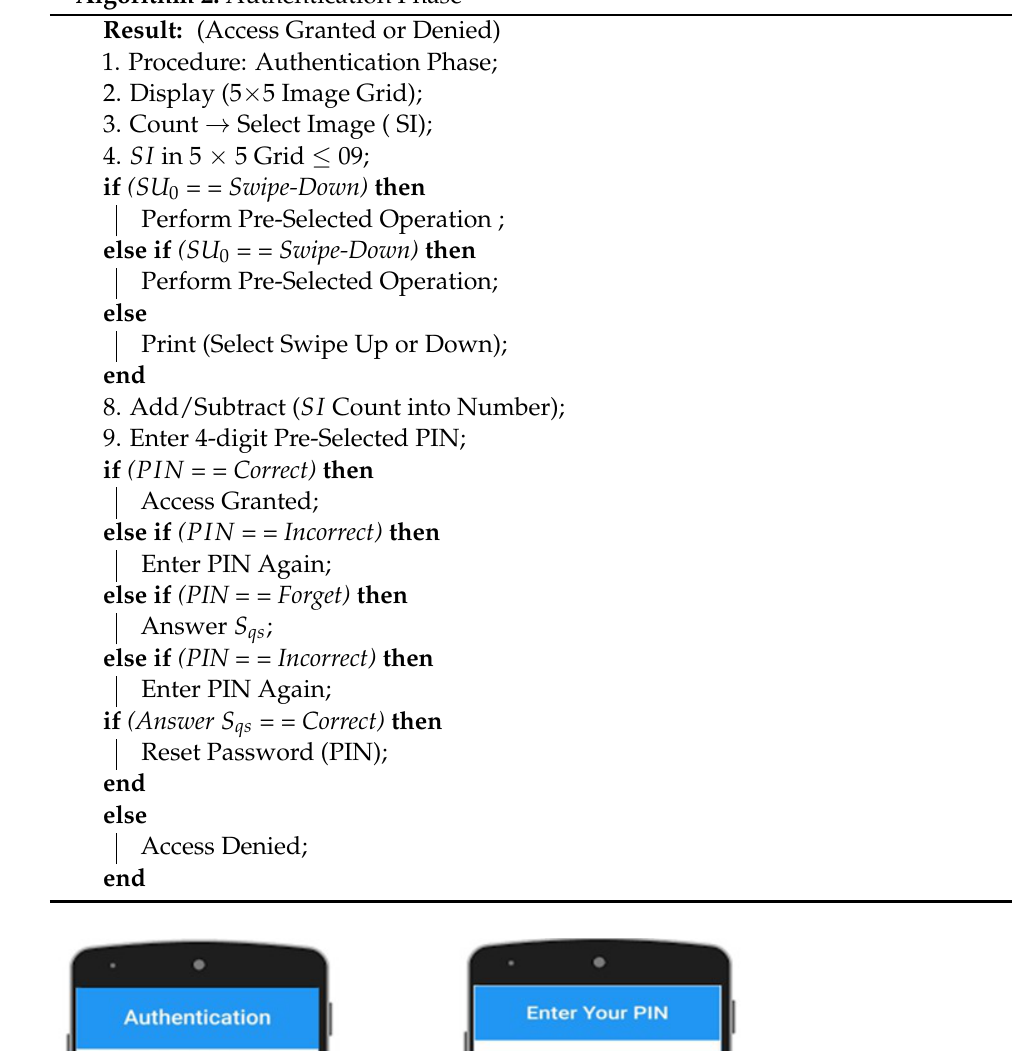
Algorithm 2: Authentication Phase